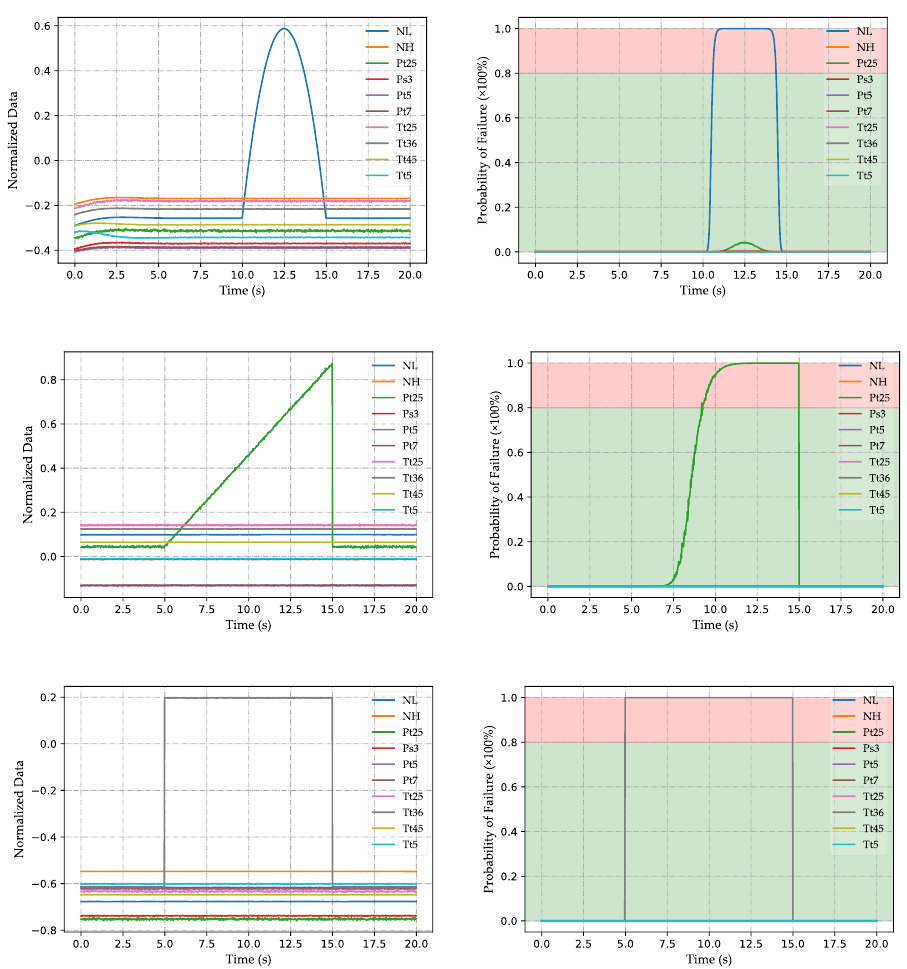
Figure 10. Detection of single sensor failure in steady state.